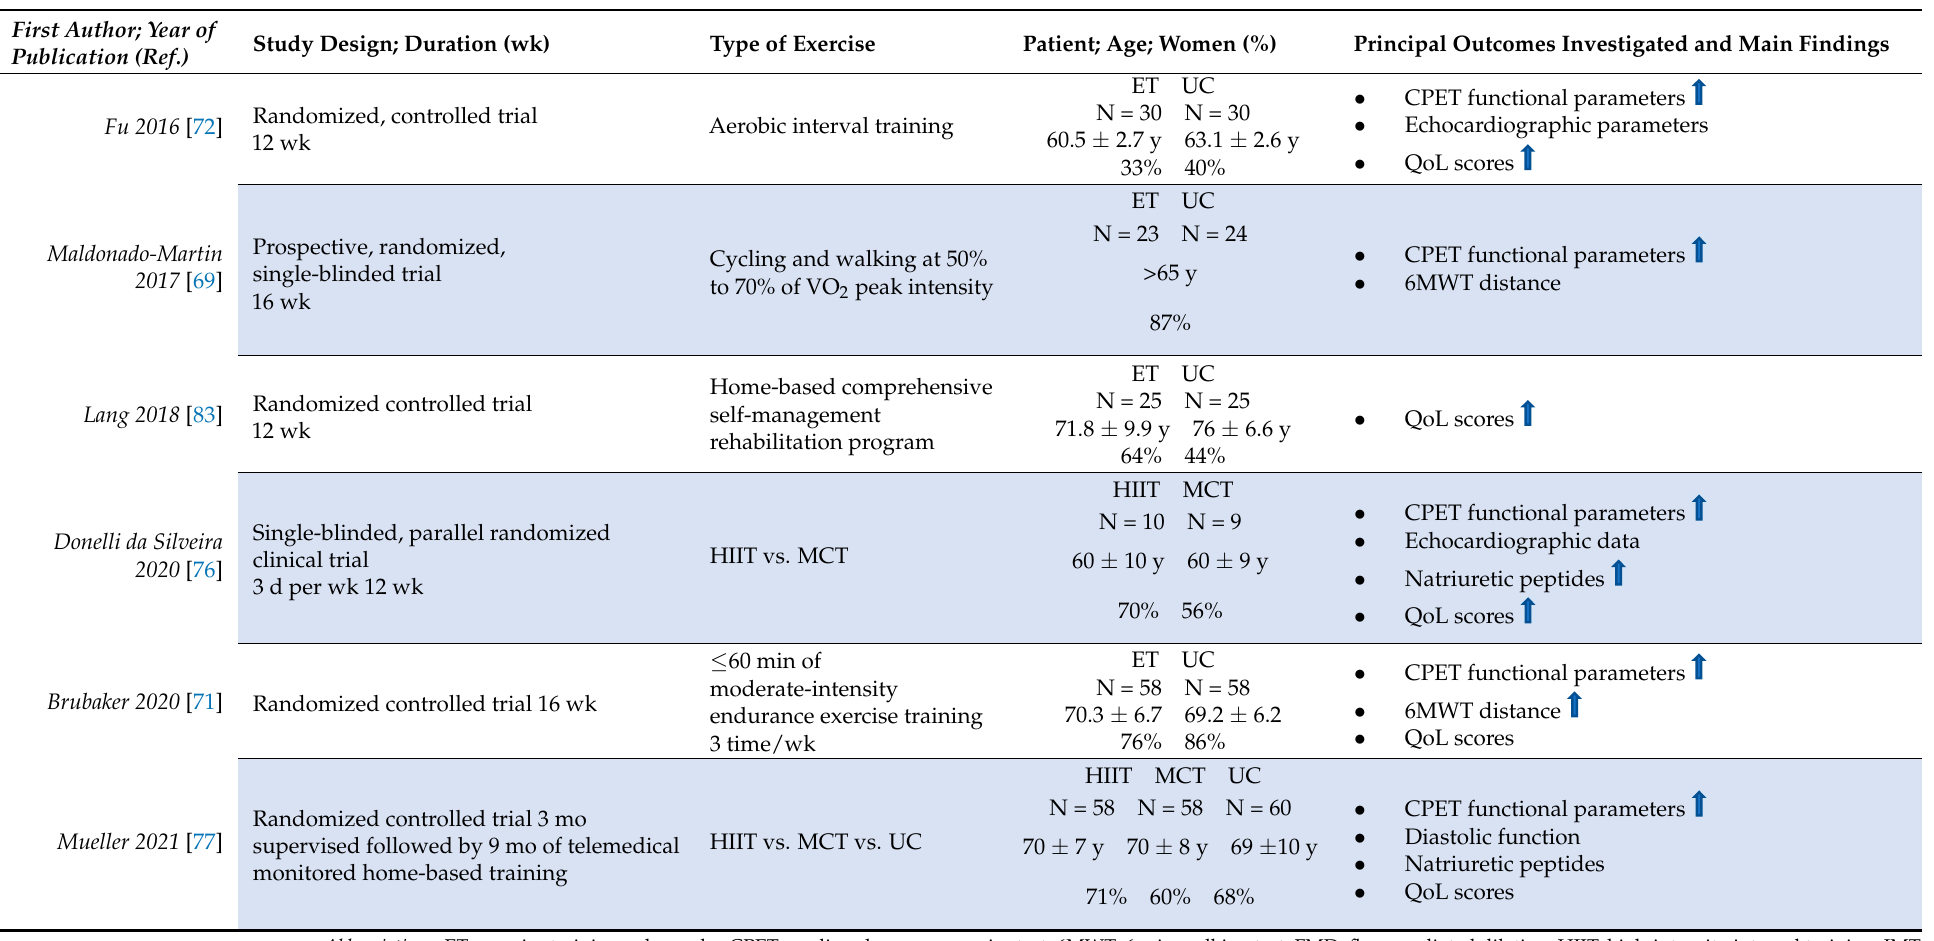
Table 7. List of studies investigating the role of exercise training in patients with preserved ejection fraction.